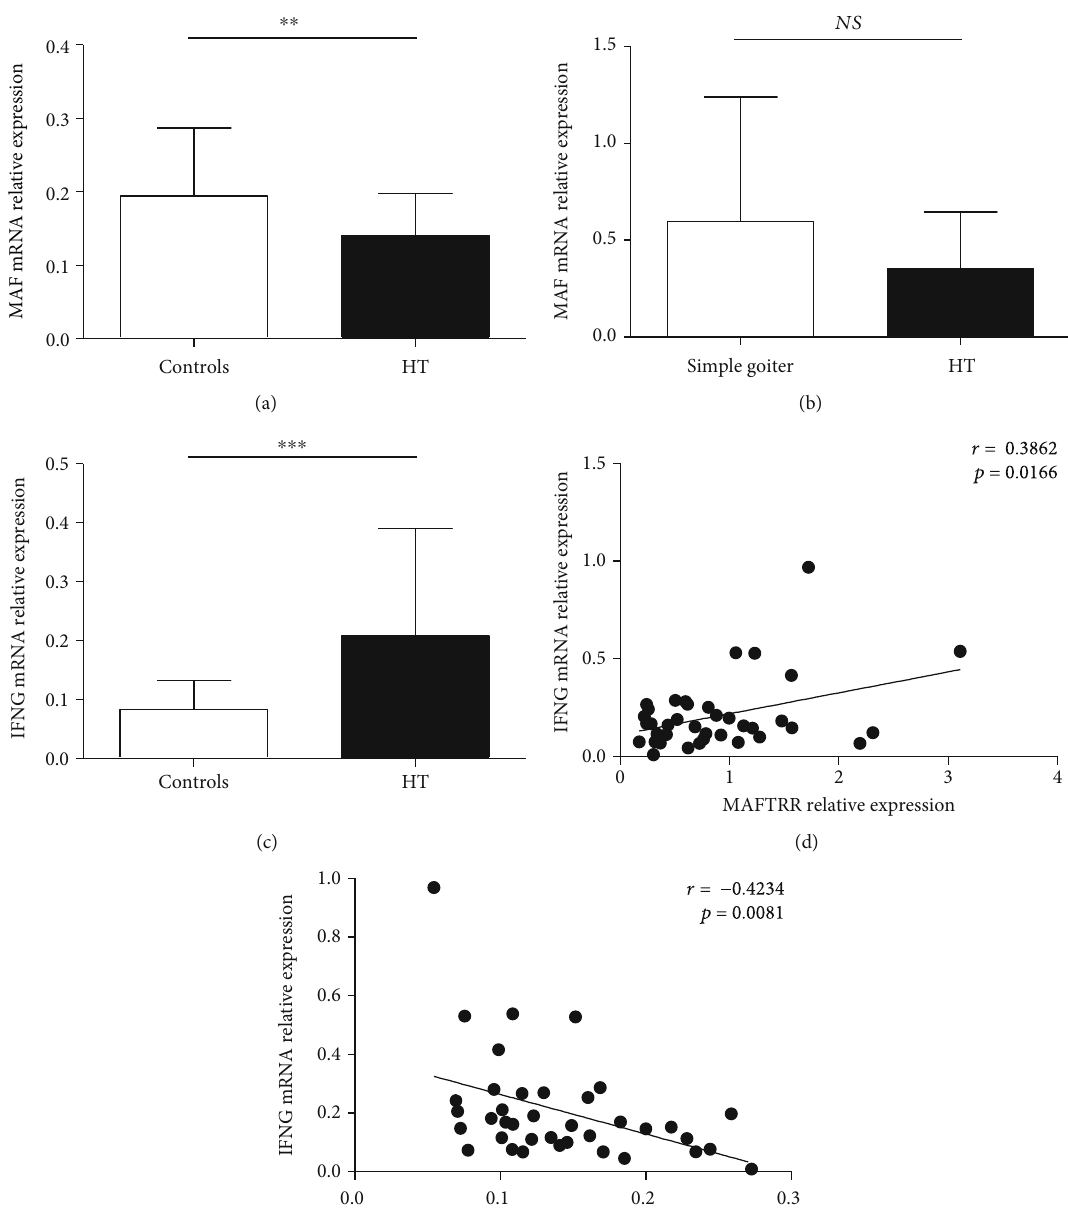
Figure 2: The comparison of MAF expression between the HT patients and healthy controls. (a) The relative expression of MAF mRNA in PBMCs from the HT patients and healthy controls was detected by qRT-PCR. (b) The relative expression of MAF mRNA in the thyroid glands of the HT patients and healthy controls was determined. (c) The relative expression of IFNG mRNA was determined in PBMCs from the HT patients and healthy controls. (d) The correlation between the transcript levels of MAFTRR and the transcript levels of IFNG in PBMCs from the HT patients is shown. (e) The correlation between the transcript levels of MAF and the transcript levels of IFNG in PBMCs from the HT patients was shown. Each data point represents an individual subject, and the horizontal lines show the mean. ∗∗ p < 0 : 01 , ∗∗∗ p < 0 : 001 . NS : no signi fi